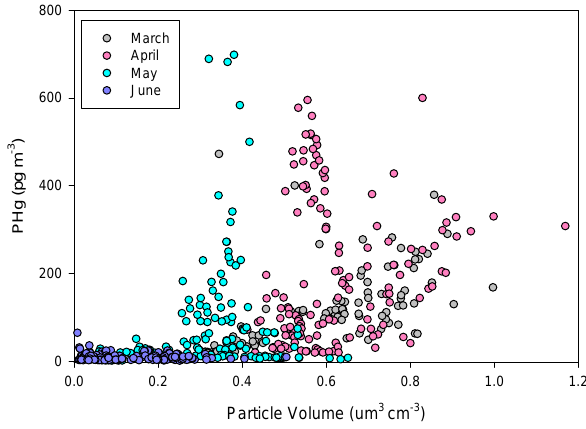
Fig. 6. Particulate mercury (PHg) concentration (pgm − 3 ) as a func- tion of total volume concentration of particles (<500nm) for the months March, April, May and June 2011 at Alert,